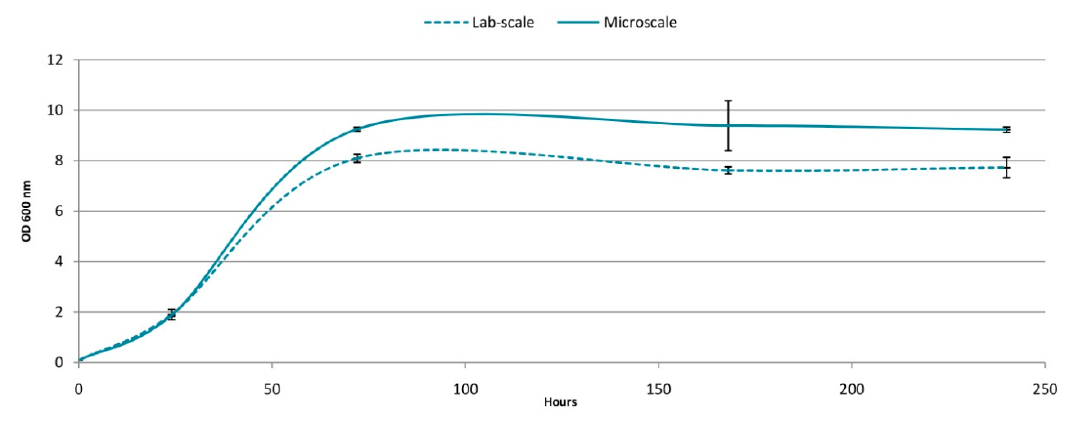
Figure 1. Fermentation performance in labscale wine and microwine.